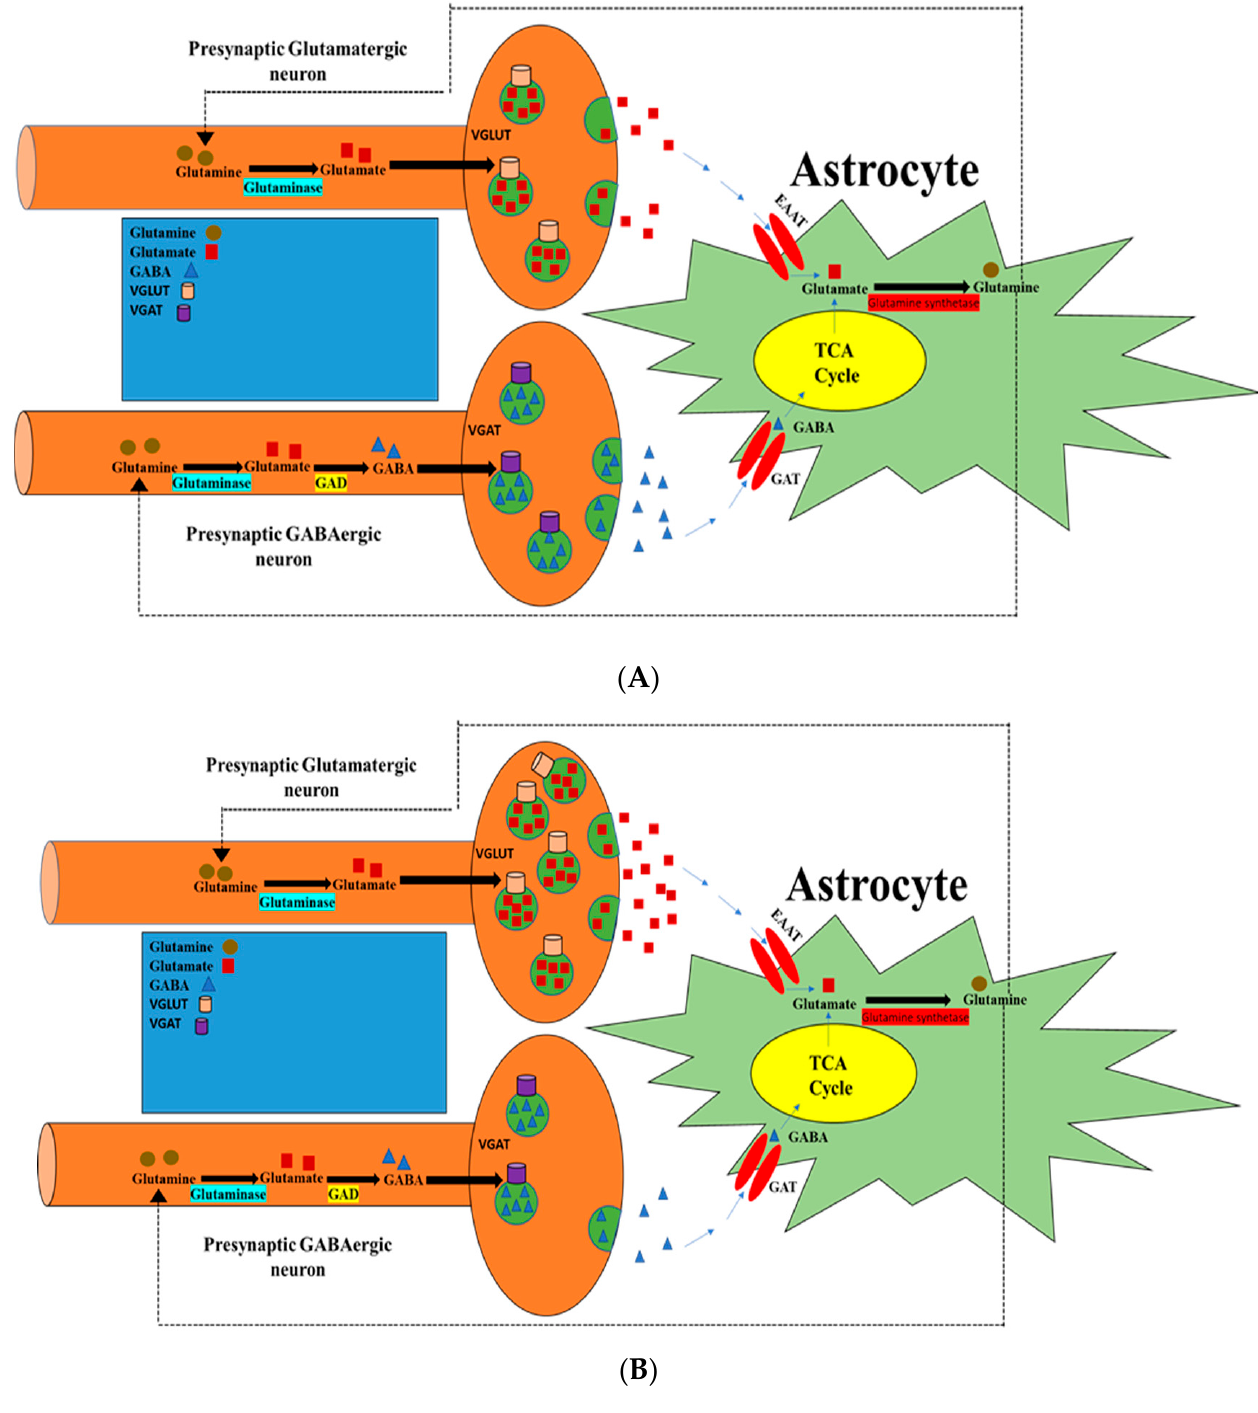
Figure 11. Schematic showing the effects of nicotine on expression of VGLUT1 and VGAT in presynaptic glutamatergic and GABAergic neurons, respectively. ( A ) Normal expression of VGLUT1 and VGAT. ( B ) E-cig aerosols containing nicotine modulate expression of VGLUT1 and VGAT and, consequently, the release of glutamate and GABA. This diagram does not include effects on different parameters identified in other studies. VGLUT, vesicular glutamate transporter; VGAT, vesicular GABA transporter; EAAT, excitatory amino acid transporter; GAD, glutamate decarboxylase; GAT, GABA transporter; TCA, tricarboxylic acid.